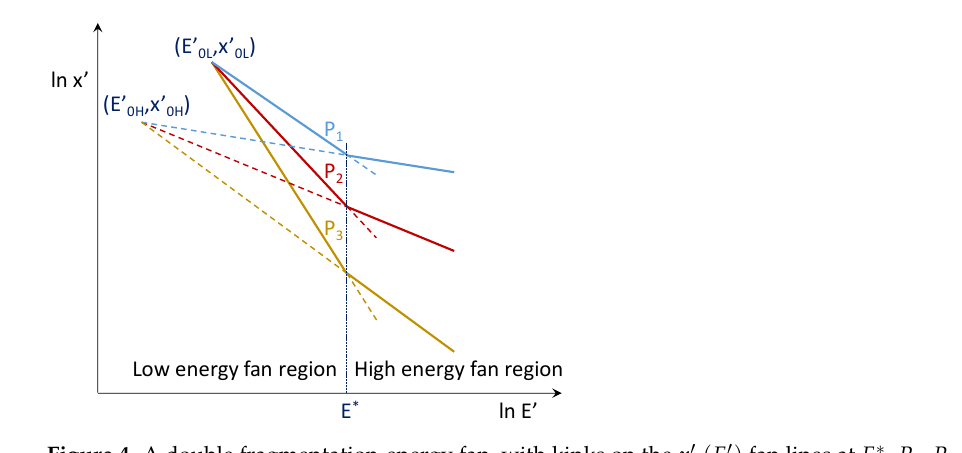
Figure 4. A double fragmentation-energy fan, with kinks on the 𝑥 𝑃′ (𝐸′) fan lines at 𝐸 ∗ . P 1 , P 2 , P 3 are percentage passing, P 1 > P 2 > P 3 .